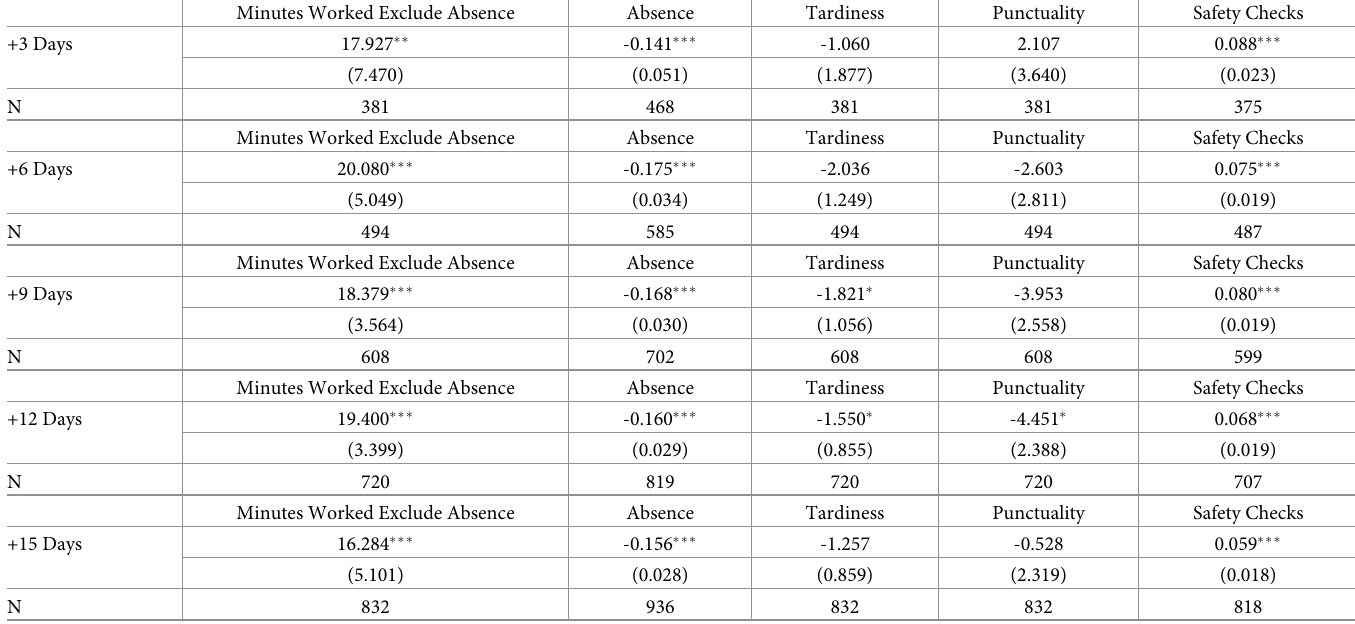
Table 1. Main regression